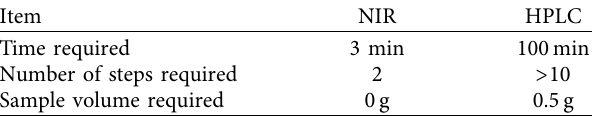
Table 8: Comparison of NIR and HPLC